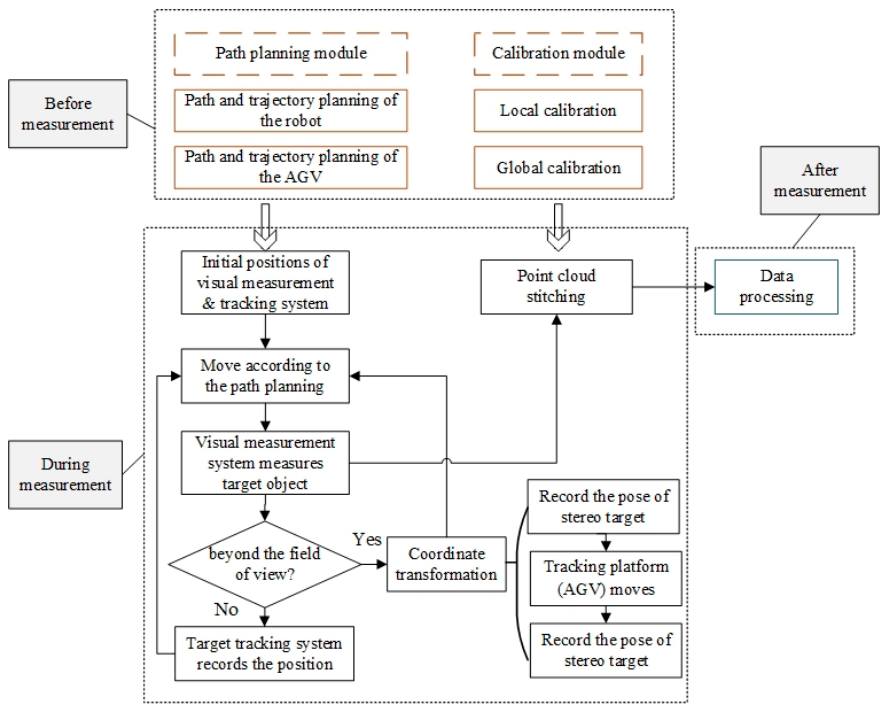
Figure 5. Schematic diagram of the workflow.